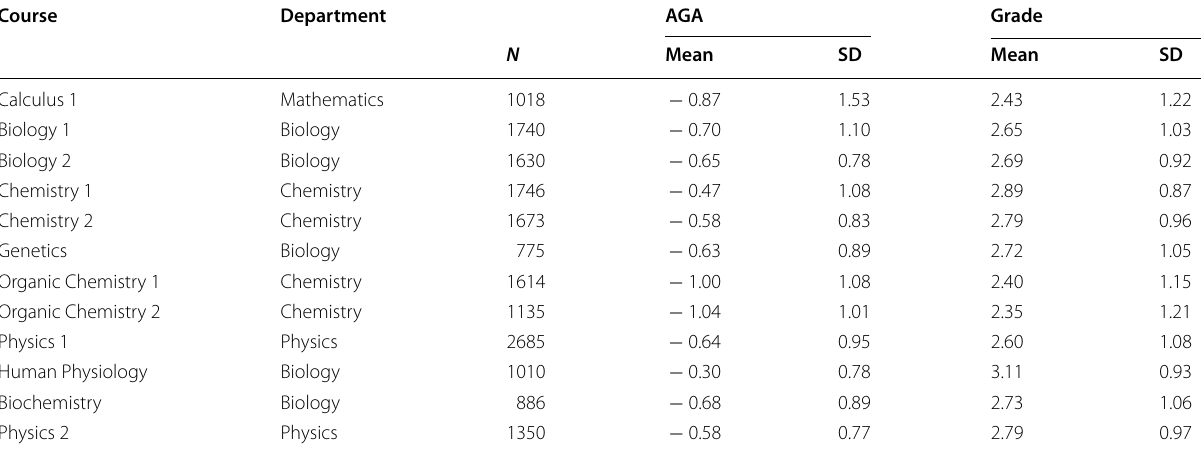
Mean and standard deviation (SD) of average grade anomalies (AGA) and grades, as well as number of students ( N ) of each course of interest